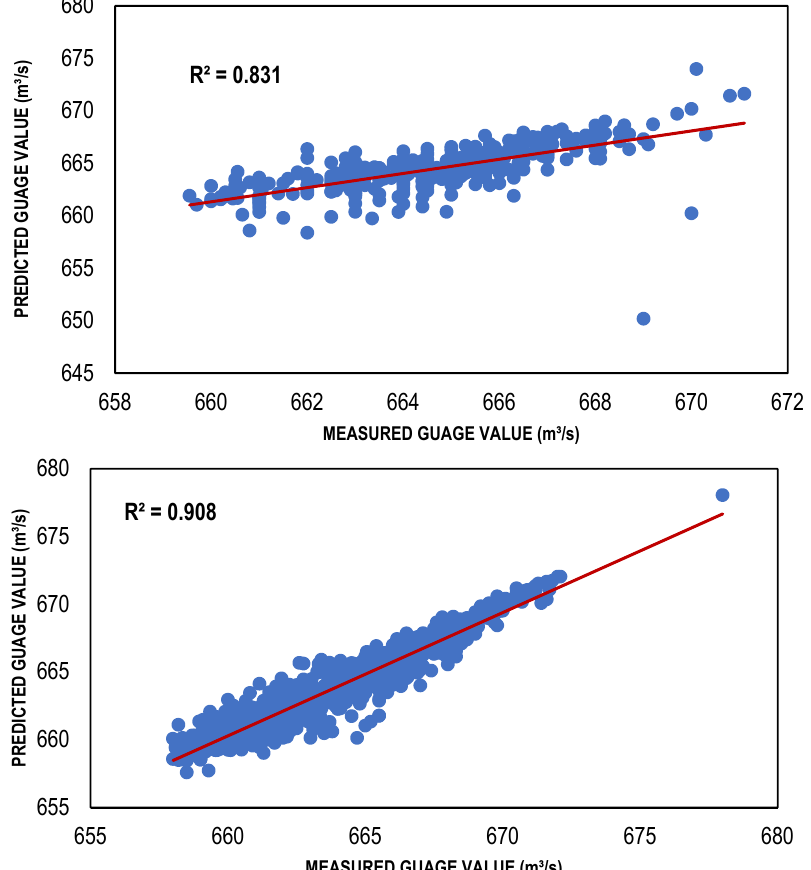
Figure 4. Best LLR-based models (training and testing).